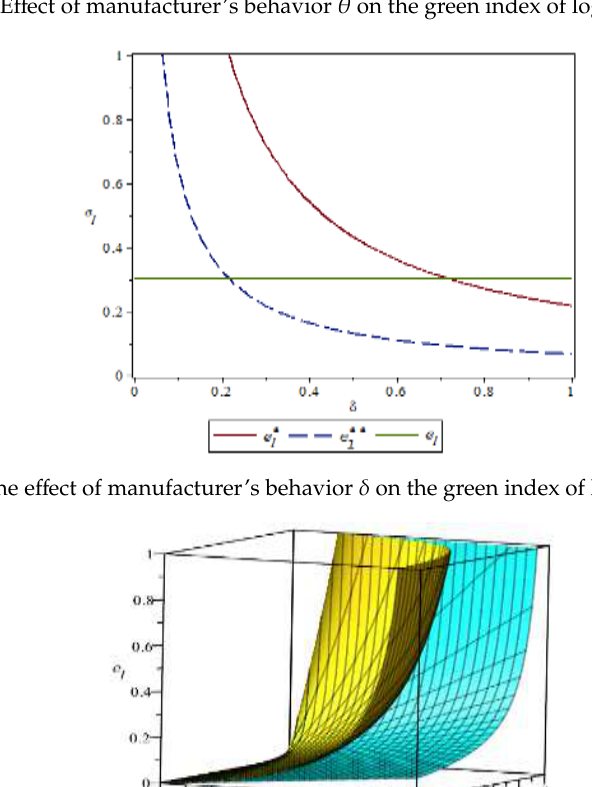
Int. J. Environ. Res. Public Health 2019 , 16 , x FOR PEER REVIEW Figure 3. Effect of manufacturer's behavior θ on the green index of logistics networks. Figure 3. E ff ect of manufacturer’s behavior θ on the green index of logistics networks.